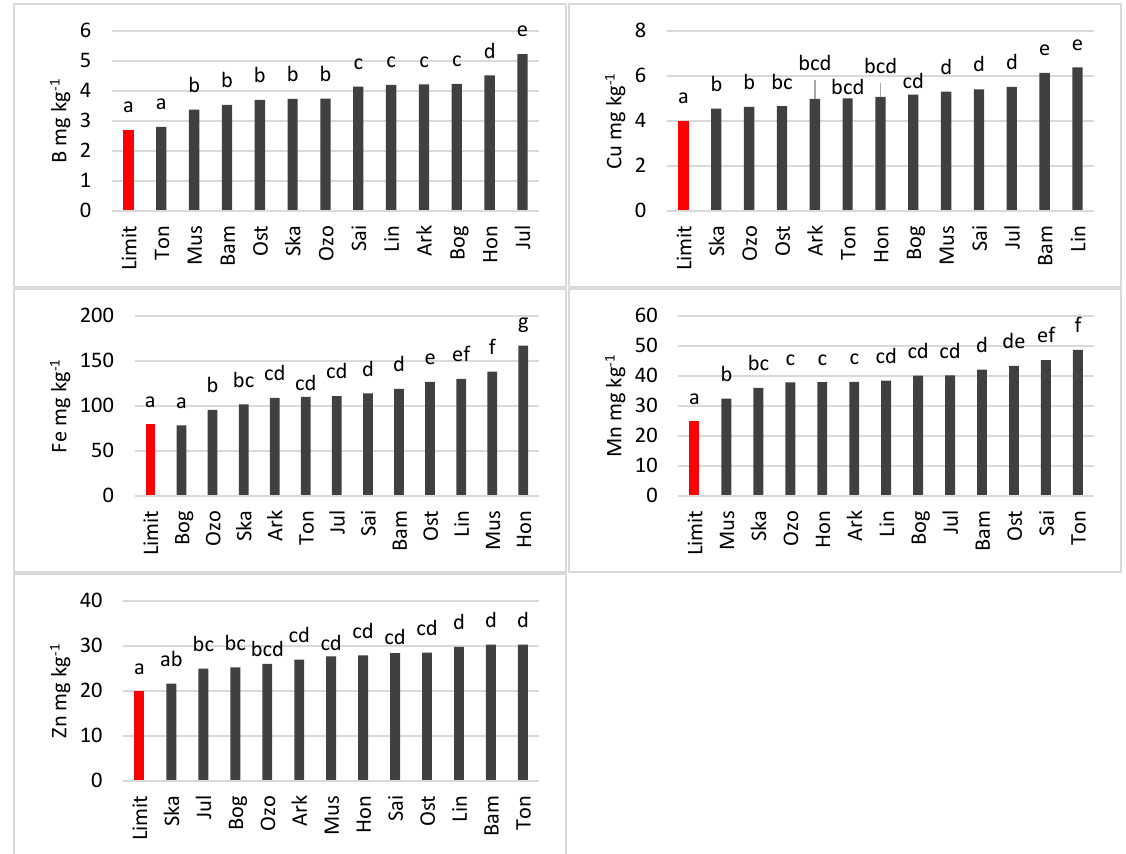
Figure 4. Concentration of microelements in shoots of wheat cultivars. Bars marked with the same letters indicate no significant difference according to Tukey ’ s test ( p < 0.05).